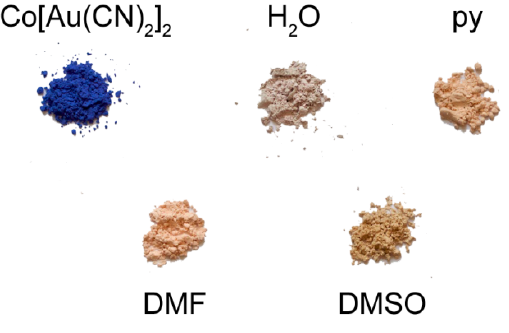
] ( top left ), Co( μ -OH 2 2 ( top right ), Co[Au(CN) 4 ( bottom right ). The latter three were synthesized by vapour 2 ] 2 2